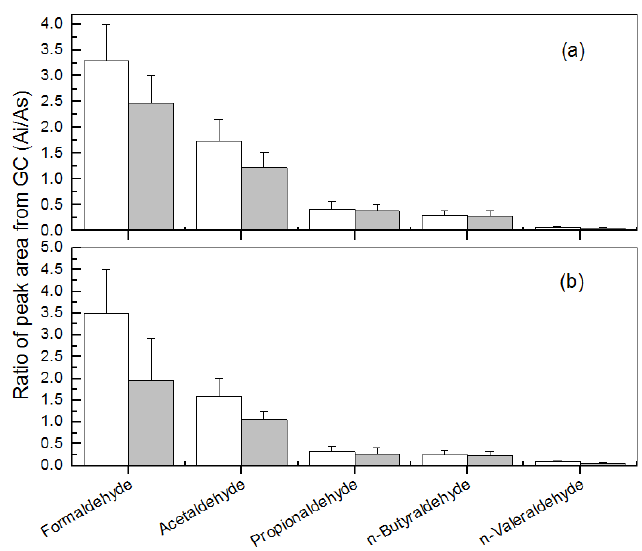
Figure 4. The ratios of peak area derived from GC of C 1 –C 5 aldehydes (Ai) to internal standard (As) from the inlet gas (white bars) and the outlet gas (grey bars) of the Schefflera octophylla (Lour.) Harms ( a ) and Chamaedorea elegans (Lour.) Harms ( b ), species enclosed in the chamber at light intensity of about 600 lx respectively. Mean ± S.E. are shown.